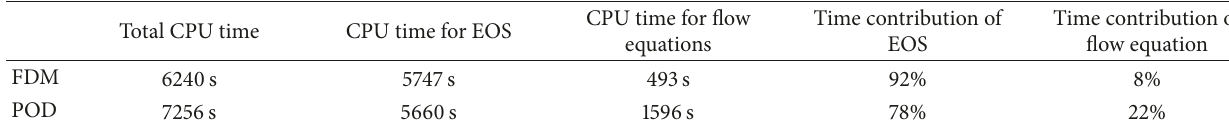
Table 4: Computational time analyses in the case of real gas.